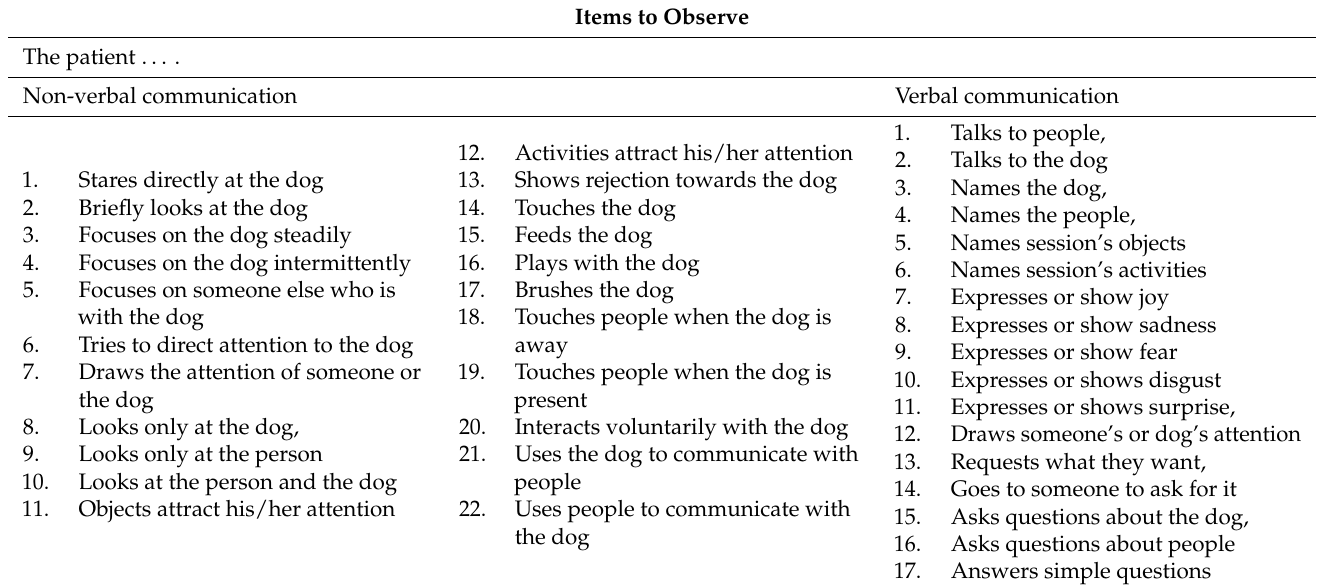
Table 3. Items observed to evaluate the patients’ communication and interaction during the sessions. Items to